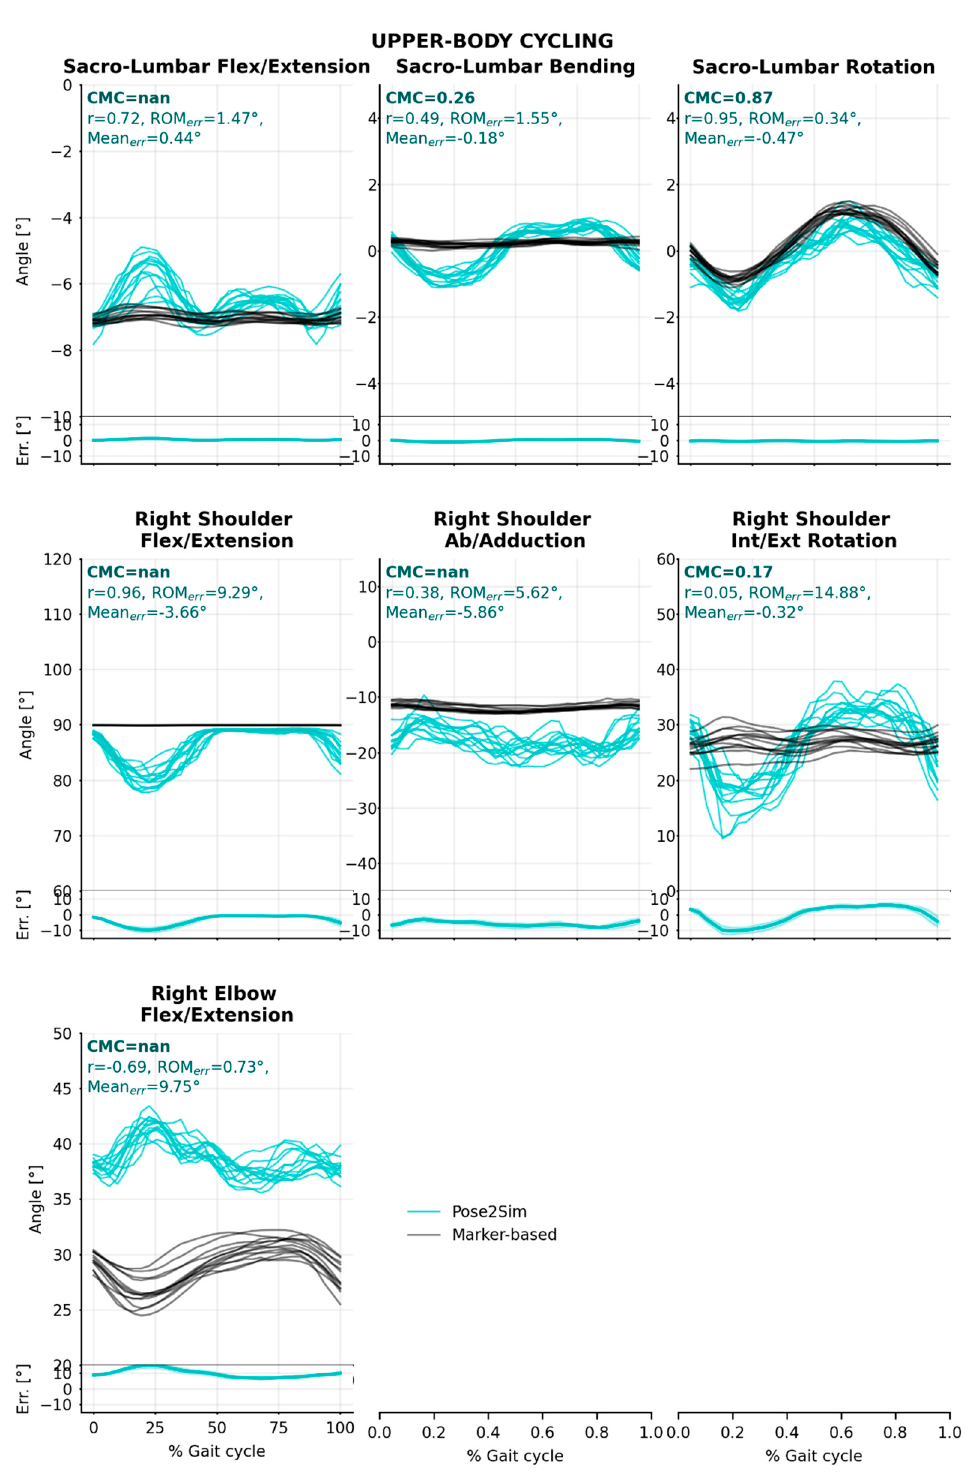
Figure A9. Pose2Sim (cyan) and marker-based (black) sacro-lumbar and upper-body joint angles for the cycling task. Coefficient of multiple correlation (CMC) is indicated, and broken down into, respectively, Pearson’s coefficient (r) for correlation assessment, range of motion errors (ROM err ) for gain, and overall mean errors (Mean err ) for offset. Mean error and standard deviations are also represented at the bottom of the graphics.